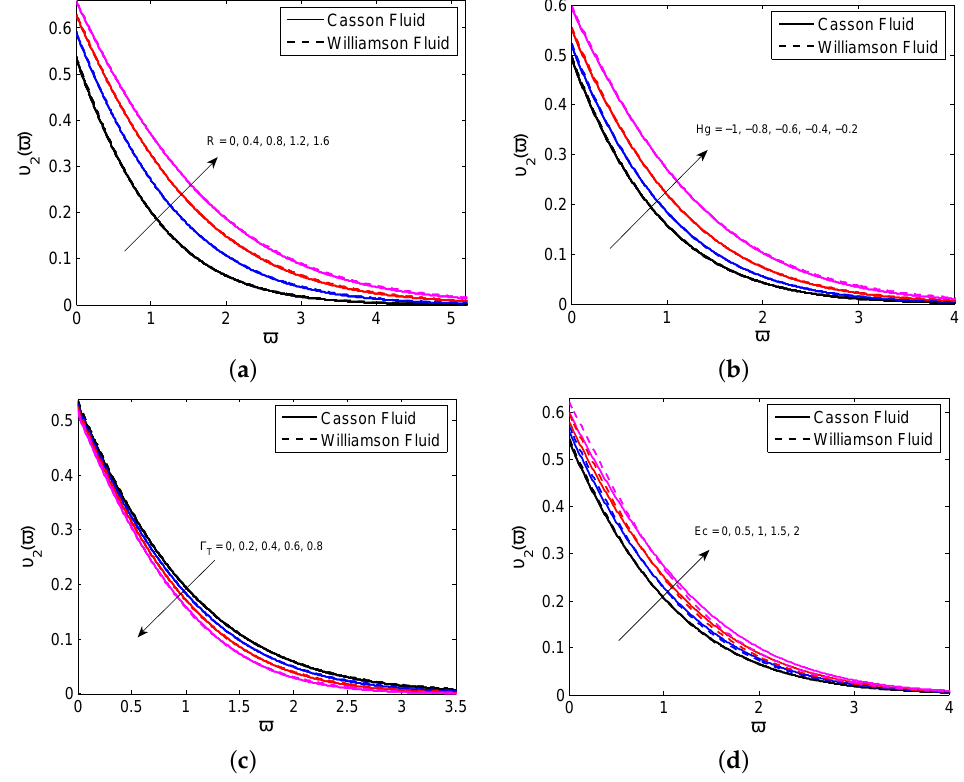
Figure 3. The nanofluid temperature profile for various vales of R ( a ), Hg ( b ), Γ T ( c ) and Ec ( d